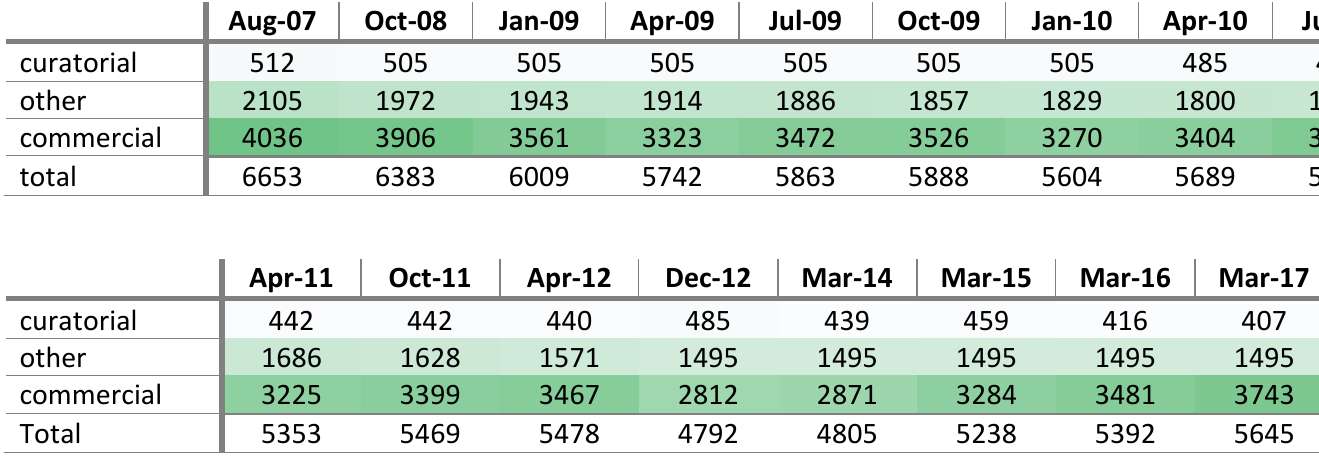
Table 8: Reported and estimated size of the archaeological sector from 2007 to